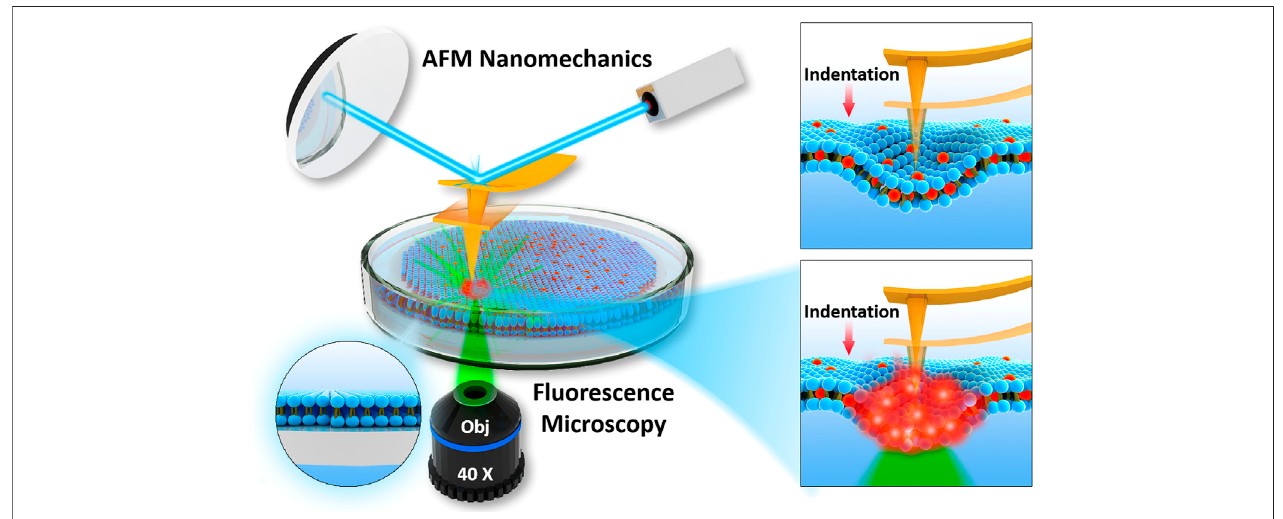
FIGURE 2 | Schematics of integration of AFM with fl uorescence microscopy used to determine nanomechanics of phospholipid bilayers interacting with fl uorophore and focused laser